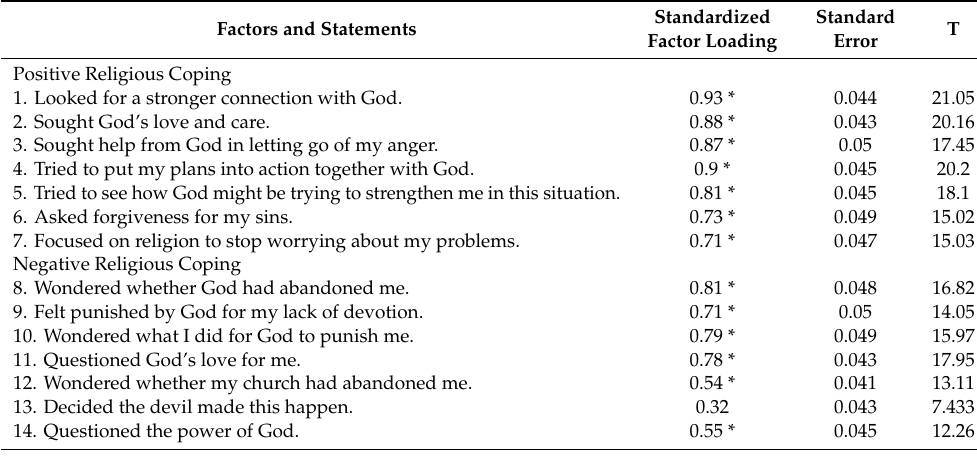
Table 3. RCOPE Factor Loadings, Standard Error, and T-statistics.